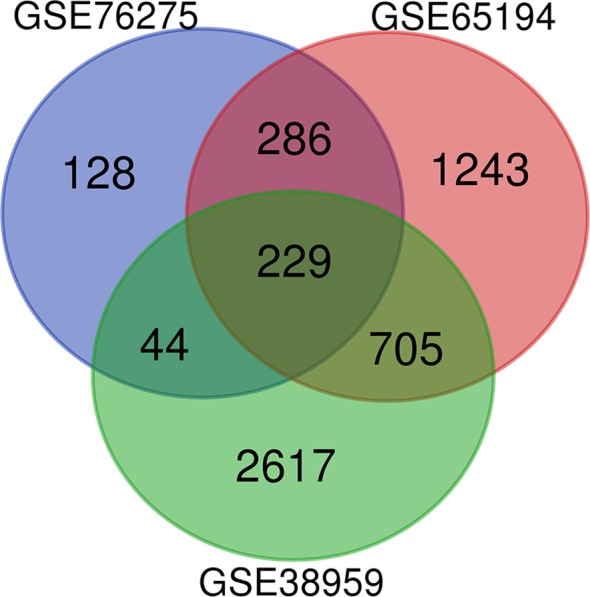
DEGs between TNBC were identified by three transcription profile datasets (GSE38959, GSE65194, GSE76275). DEGs were identified with the classical t test, and statistically significant DEGs were defined using P < 0.05 and |log2 fold change (FC)| > 1 as the cutoff criteria.